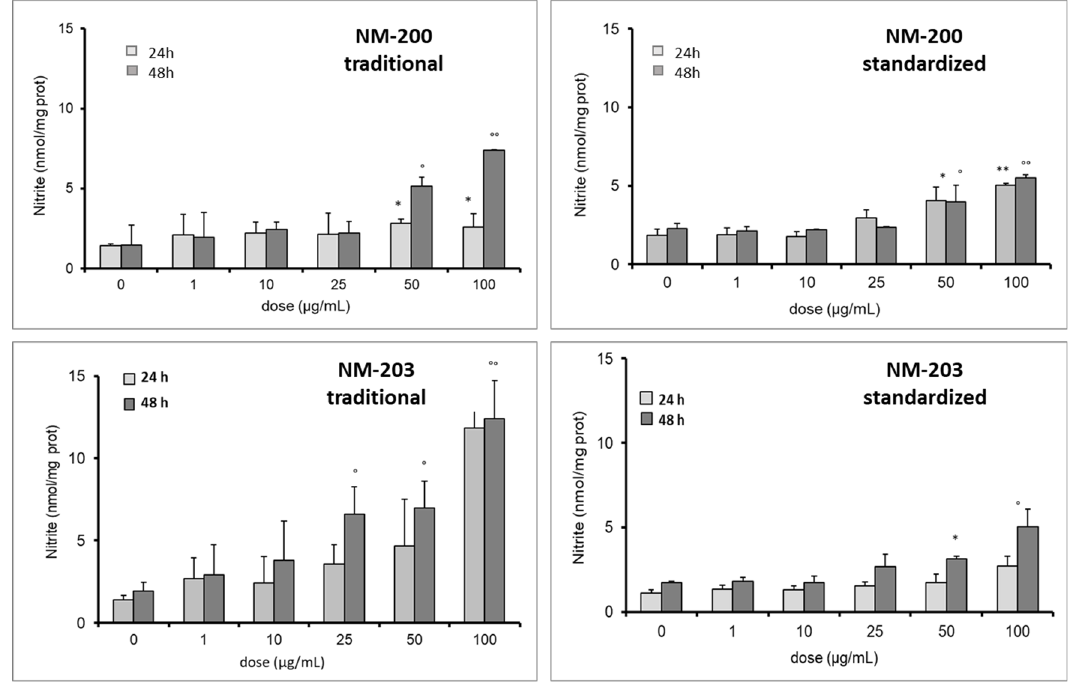
Figure 9. Effect of the dispersion protocols on the induction of NO release by RAW 264.7 cells by NM-200 and NM-203. Each measurement was performed in duplicate, and data are presented as means ± SEMs (n = 3 readings): ** p < 0.01 vs. ctrl; * p < 0.05 vs. ctrl; ◦◦ p < 0.001 vs. ctrl; ◦ p < 0.05 vs. ctrl.